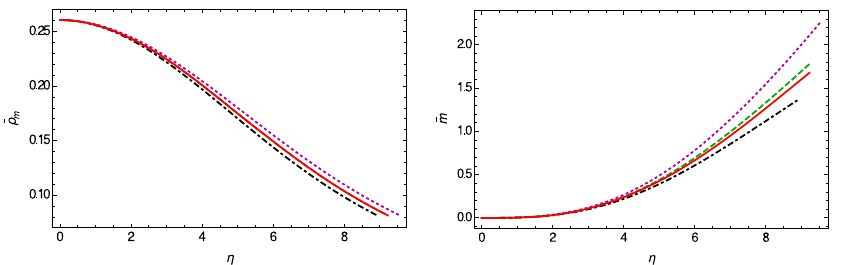
Fig. 8 Variation of the energy density ¯ ρ m (left panel) and of the mass ¯ m (rightpanel)intermsof η forthree-formfieldphotonstarsinthepres- ence of a constant field potential, for three different values of the con- stant ¯ λ : ¯ λ = 0 (dashed curve), ¯ λ = 0 . 02 (dotted curve), and ¯ λ = − 0 . 02